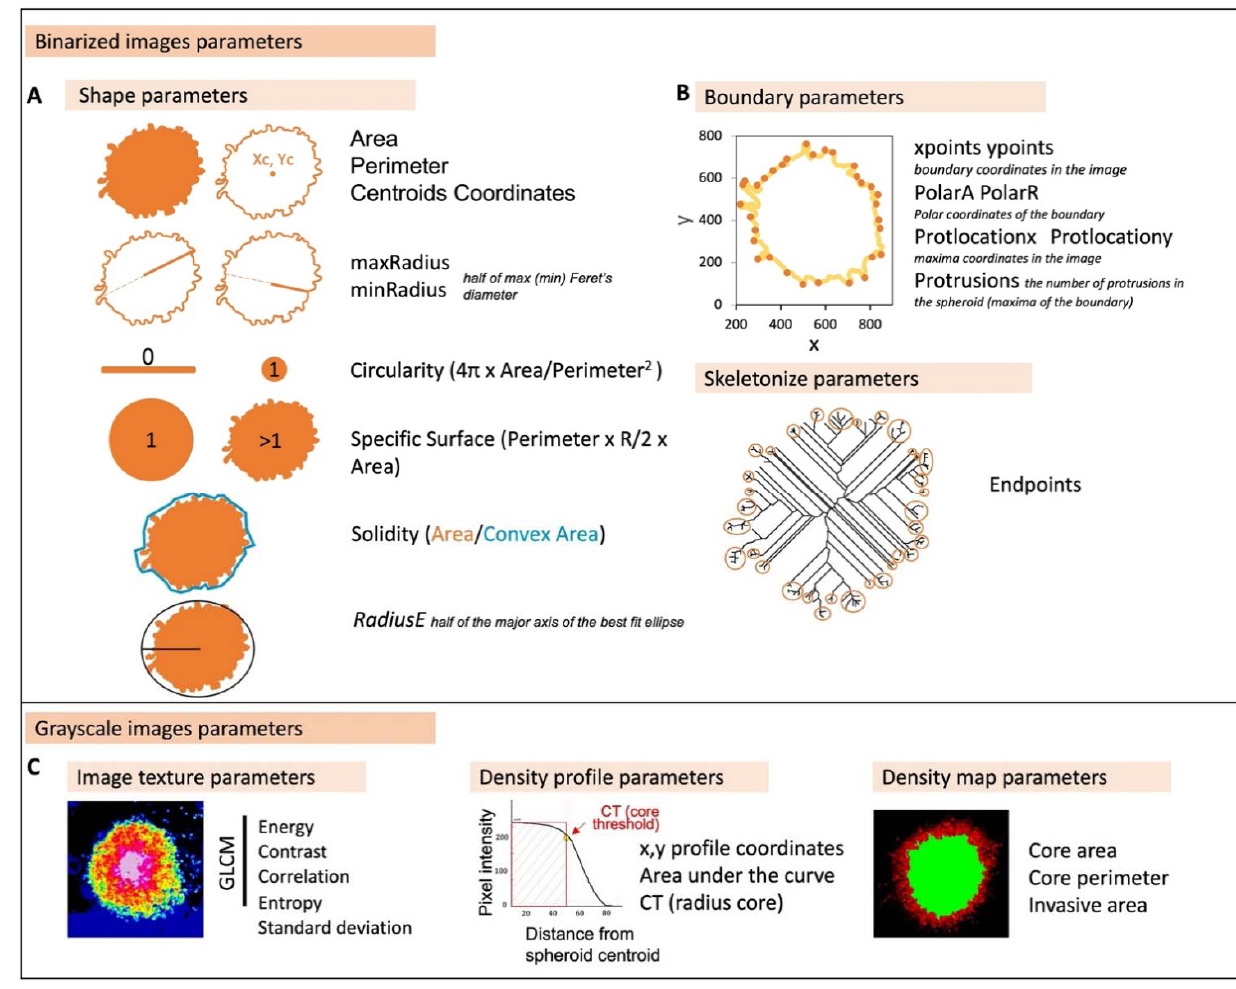
Figure 3. Overview of parameters automatically extracted by INSIDIA 2.0. ( A ) Binarized images parameters include shape parameters as well as ( B ) boundary derived parameters and skeletonized image number of endpoints. In ( C ), parameters from grayscale images are shown: image texture parameters, a new feature on INSIDIA 2.0, and density profile and map parameters.